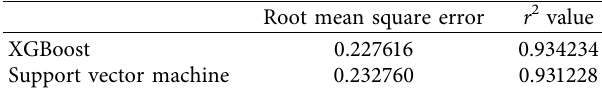
Figure 23: Comparison between real values and predicted values of Boro yield for